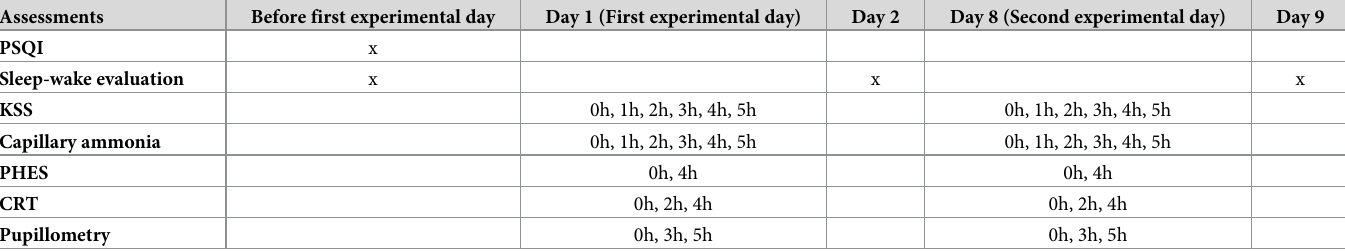
Table 1. Study assessments during the inclusion